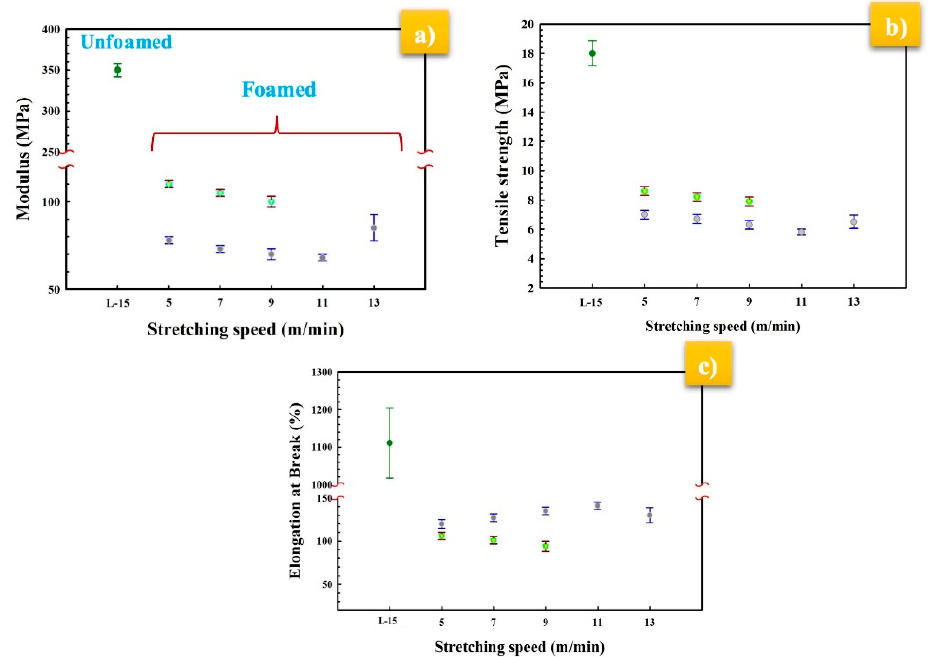
Figure 18. Effect of stretching speed on the ( a ) Young’s modulus, ( b ) tensile strength, and ( c ) elongation at break of selected MMFM15 and L-15.